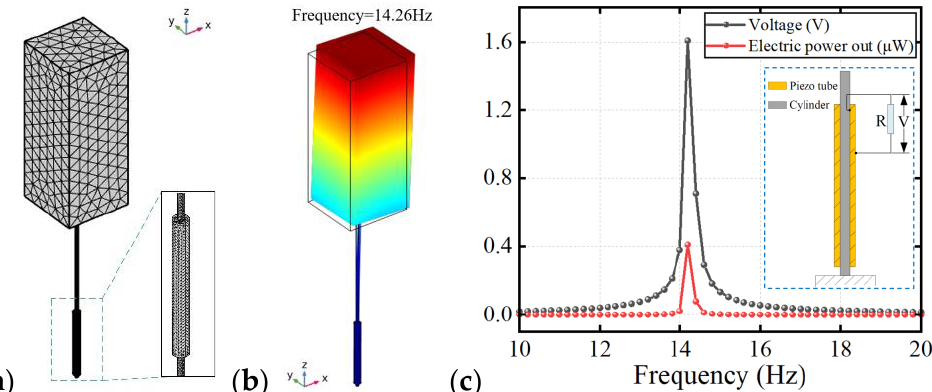
Figure 4. ( a ) Multiphysical field simulation model of the harvester. ( b ) Instant motion pattern at the first-order eigenfrequency of the harvester with square-section cylinder. ( c ) Voltage and electric power out versus frequency.